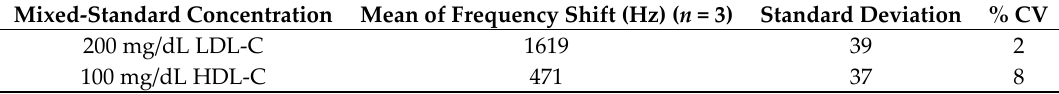
Table 2. Repeatability